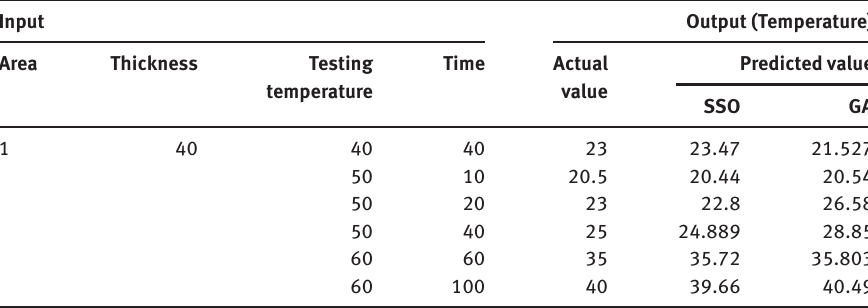
Table 2: RCC Wall Panel.